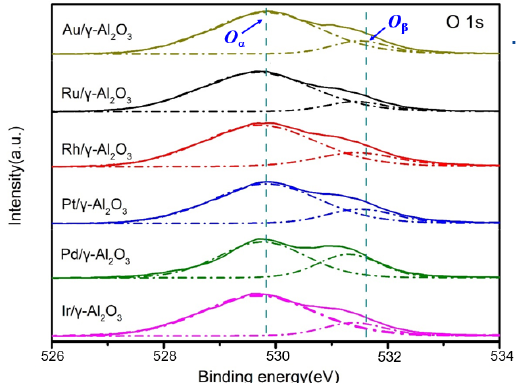
Figure 8. O 1 s spectra of all prepared noble metal-based catalysts.